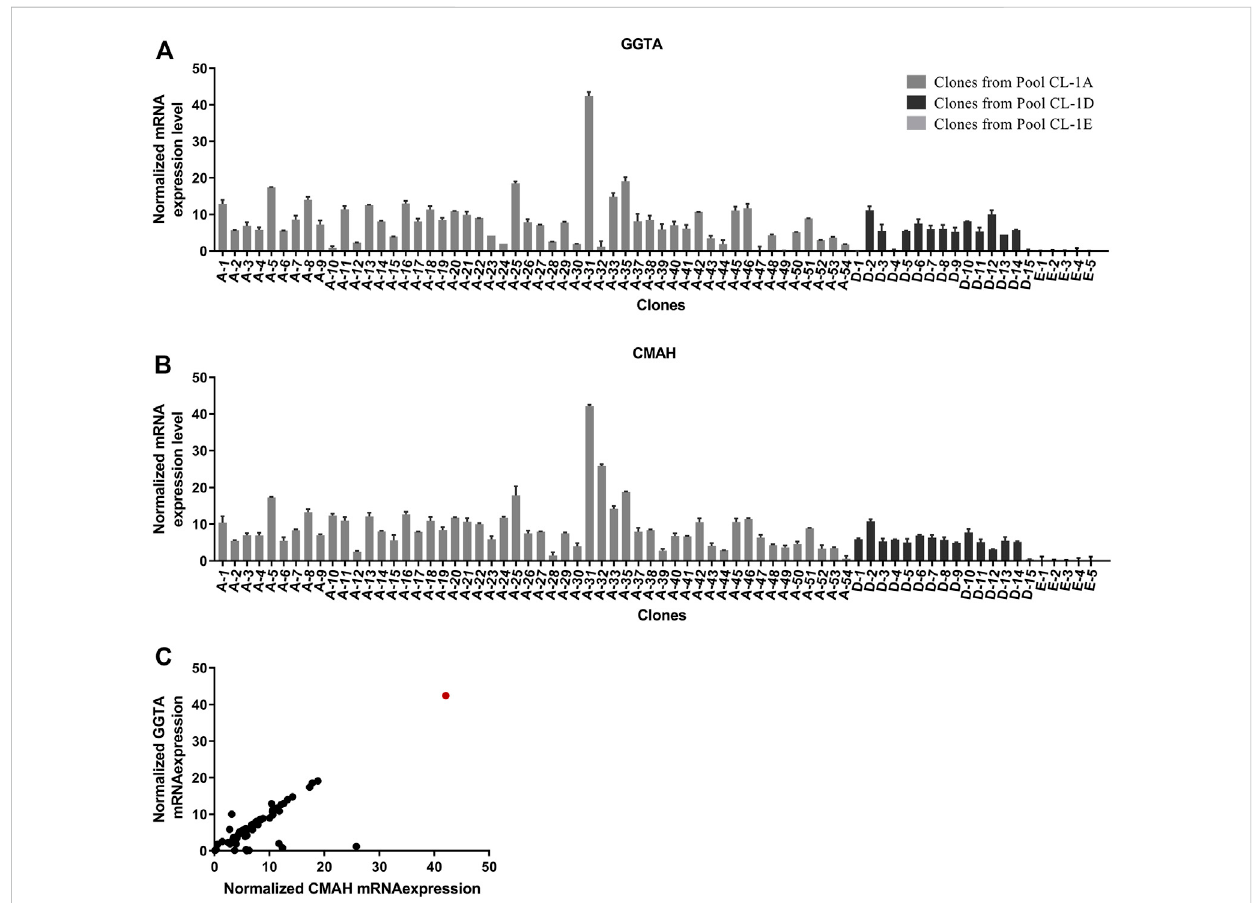
FIGURE 3 Pro fi ling of GGTA and CMAH expression and functionality in cell clones. (A, B) Day 8 mRNA transcript expression of overexpressed genes in CHO CL1 derived clones. The mRNA expression was normalized to constitutive genes Gusb and Tbp. Overexpression of (A) GGTA1 and (B) CMAH was determinedinfed-batchculturesacrossmultipleclonesgeneratedfromConstructsAandDcomparedtoControlE (C) Bi-cistronicvectorcon fi guration resulted in linked expressionof both GGTA1 and CMAH. Day 8 mRNA transcript expression of overexpressedgenes inCHO CL1 derived clones. The mRNA expression was normalized to constitutive genes Gusb and Tbp. Clone 31 is shown in the red